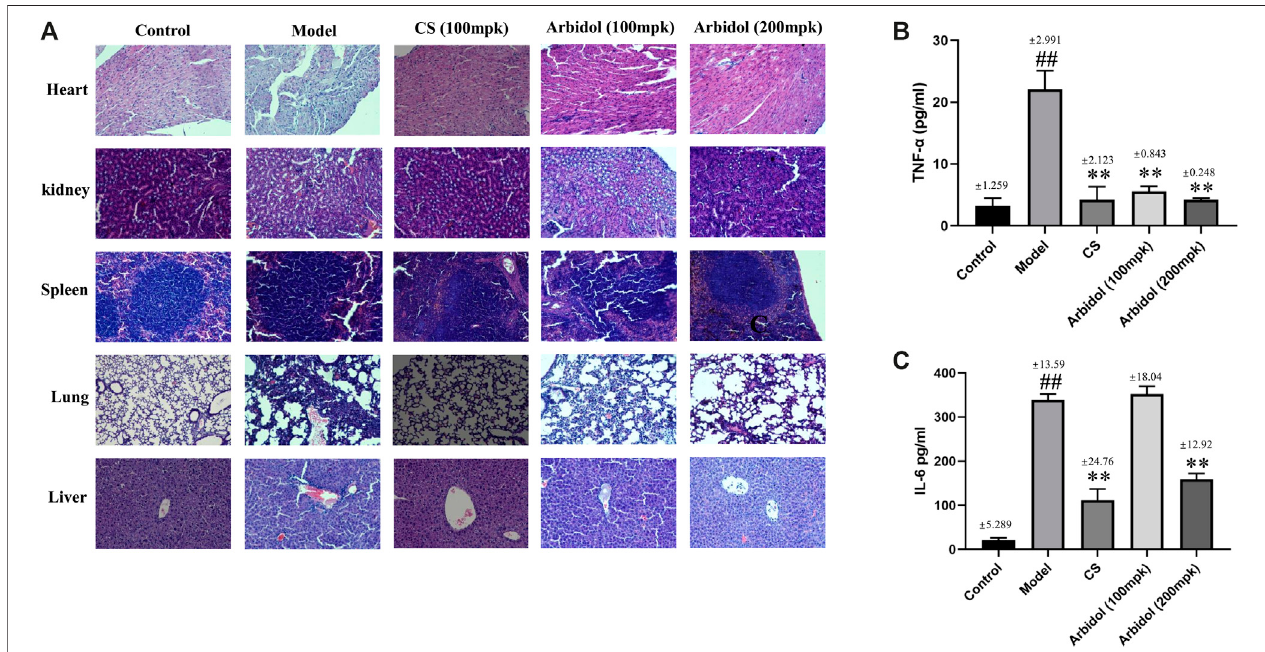
FIGURE 4 | Effect of arbidol on serum proin fl ammatory cytokine expression. (A) HE staining was used to evaluate the effect of arbidol on fecal dilution -induced pathologicalchanges(20 × magni fi cation). (B,C) SerumTNF- α andIL-6weredetectedbyELISA.Arbidolsigni fi cantlyinhibitsthelevelsofTNF- α andIL-6inmouseserum. Values are presented as the mean ± SEM (n (cid:1) 5), ## p < 0.01, signi fi cantly different from control group; ** p < 0.01, signi fi cantly different from model groups.